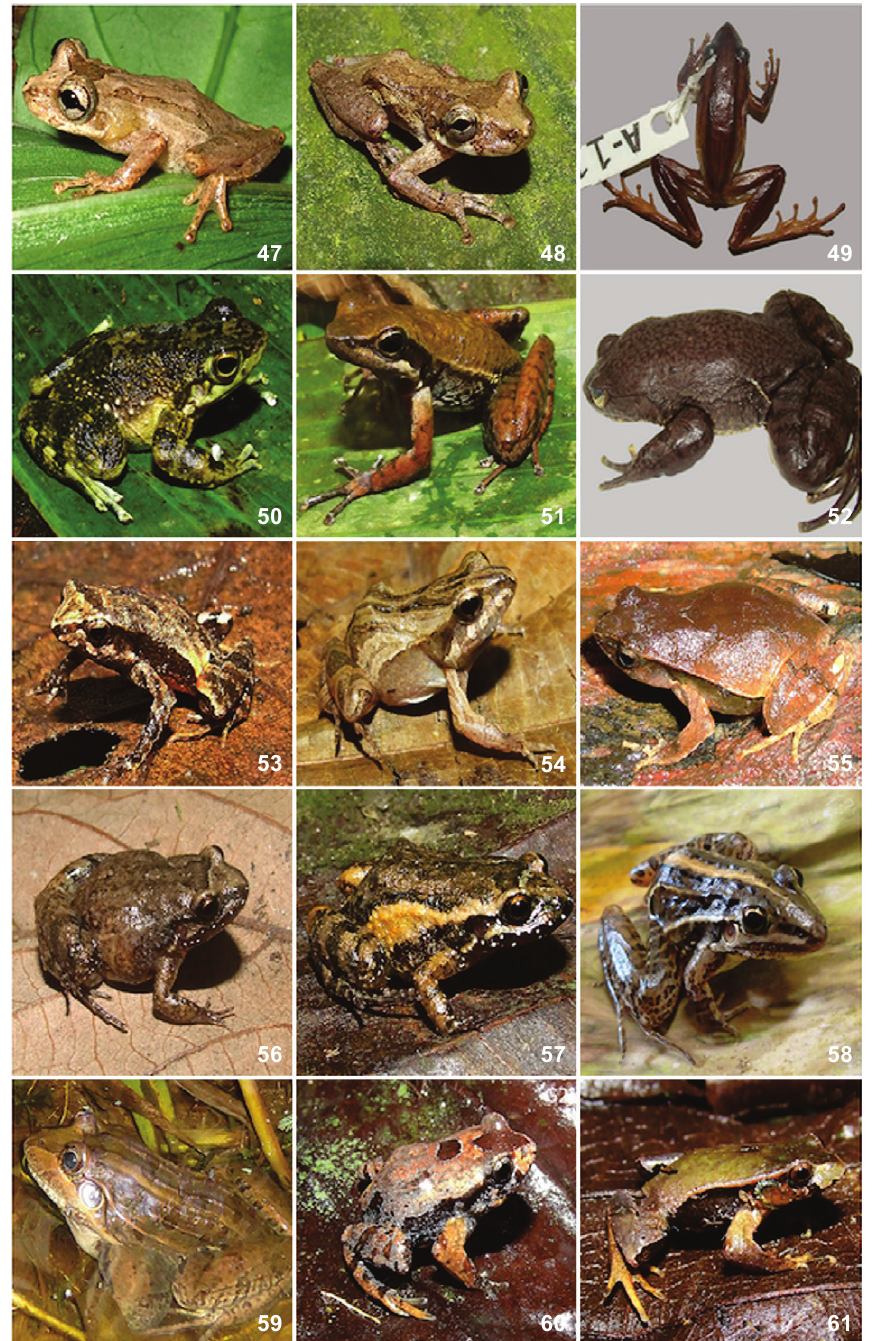
Figures 47-61. Anuran species sampled for the Parque Natural Municipal Nascentes de Paranapiacaba, Santo André, São Paulo